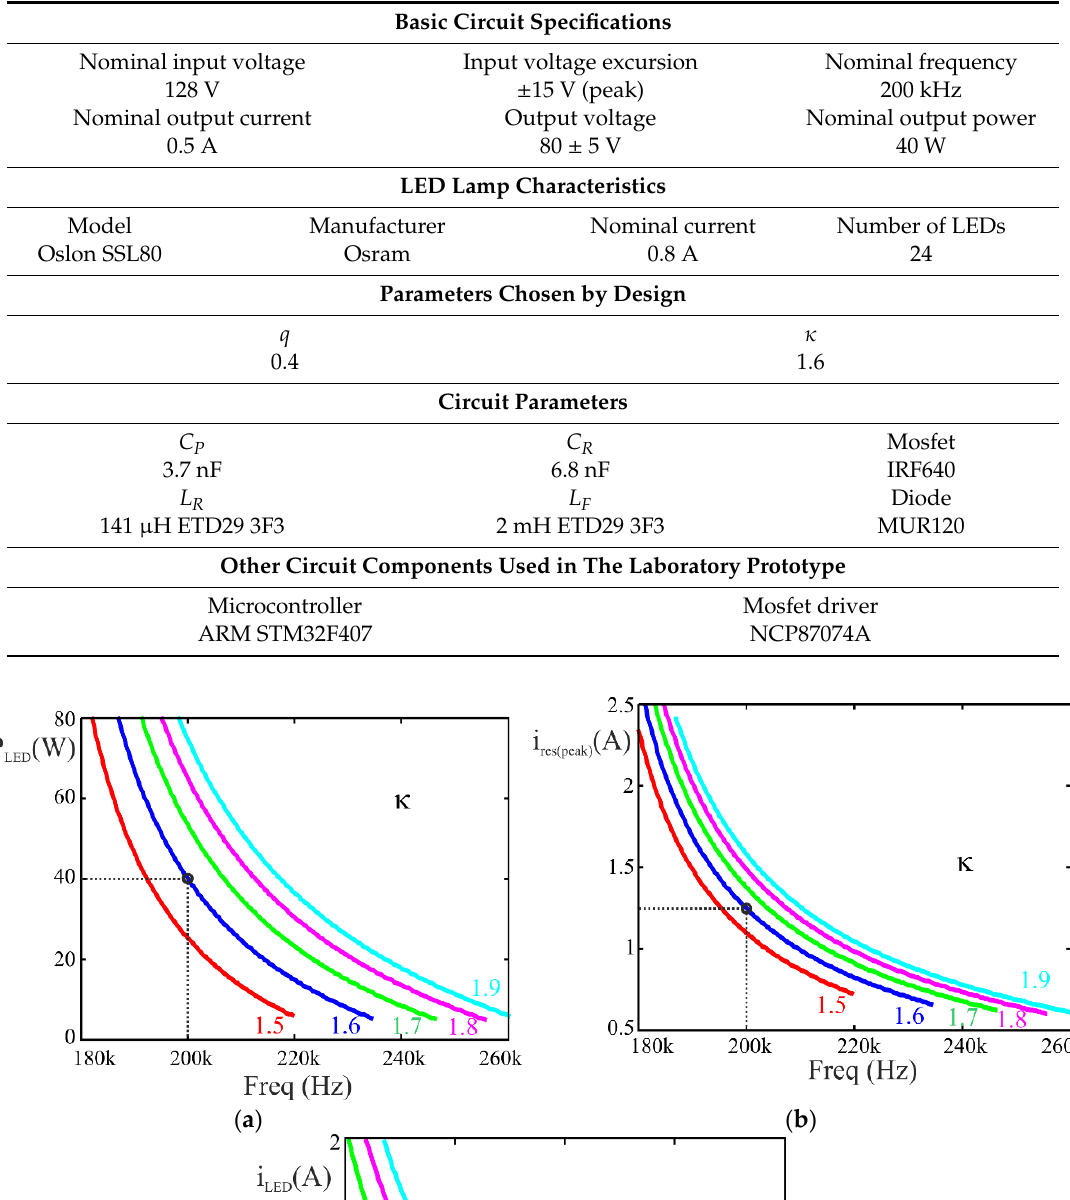
Table 1. Design example specifications.